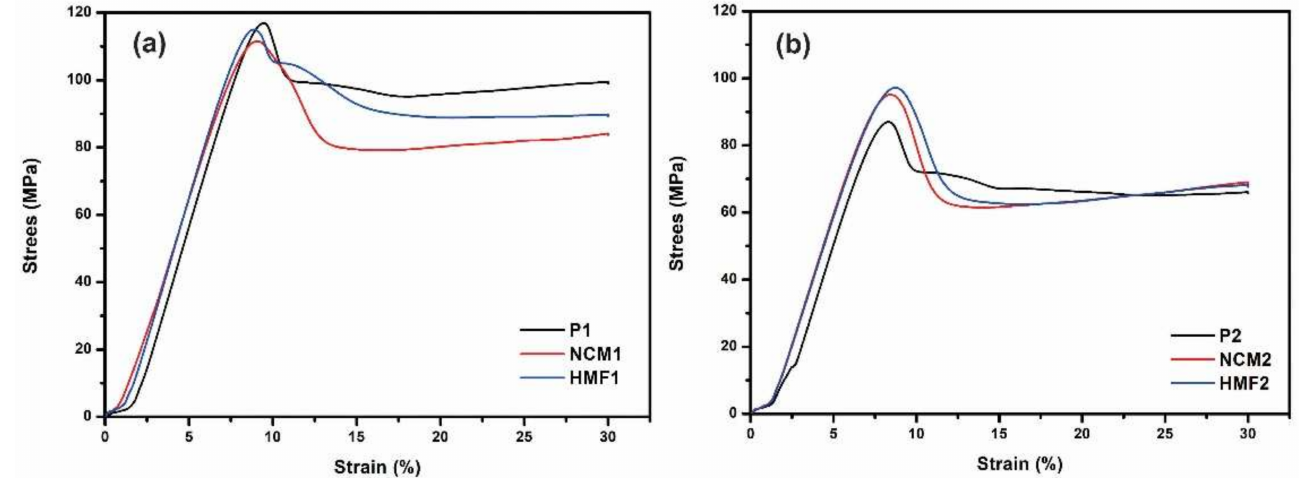
Figure 8. Graphic of the compression resistance for ( a ) test pieces made with cured resin 1 (P1), nanocomposite made with resin 1 and ZnO-NPs without functionalization (NCM1), and hybrid material (HMF1) and ( b ) test pieces made from cured resin 2 (P2), nanocomposite made from non- functioning resin 2, and ZnO-NPs (NCM2) and hybrid material